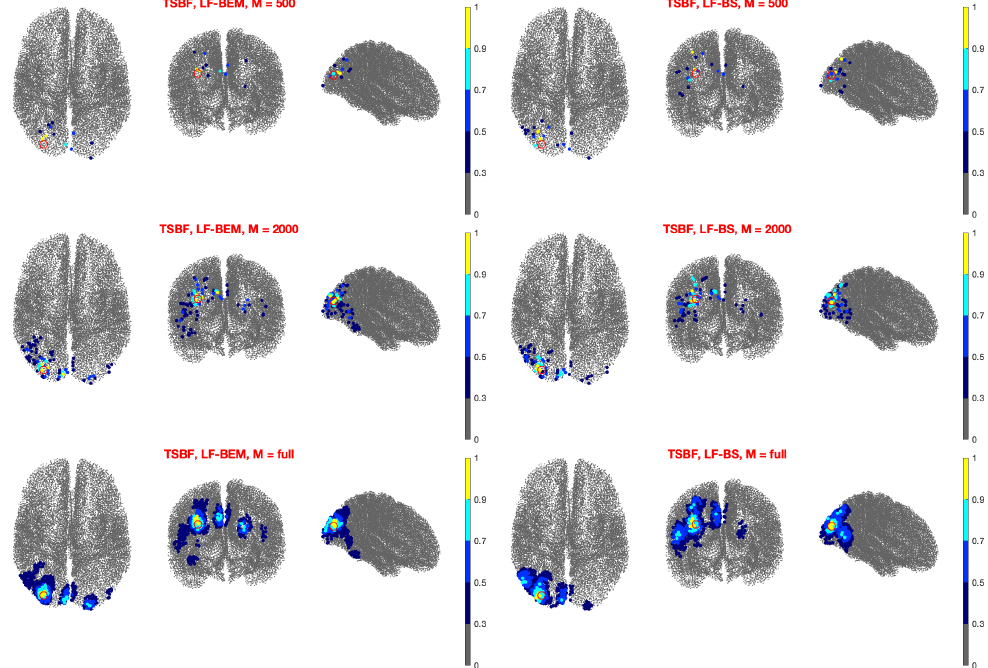
Figure 15. Right Visual evoked field: The intensity of the estimated sources, averaged over N = 10 runs, at 90 ms obtained using TSBF with M = 500 random points (first row), M = 2000 (second row) and the full source space (third row) for LF-BEM (left column) and LF-BS (right column). The red circle represents the dipole fitted using